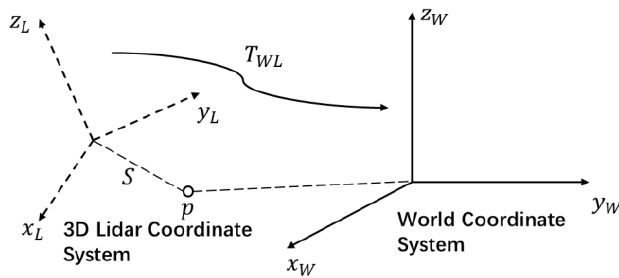
Figure 4. Distance-weight map construction diagram.